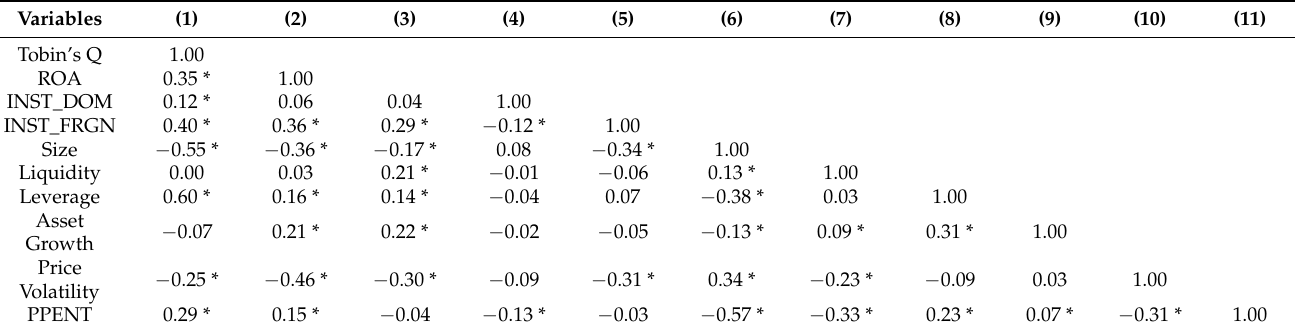
Table 3. Pair-wise